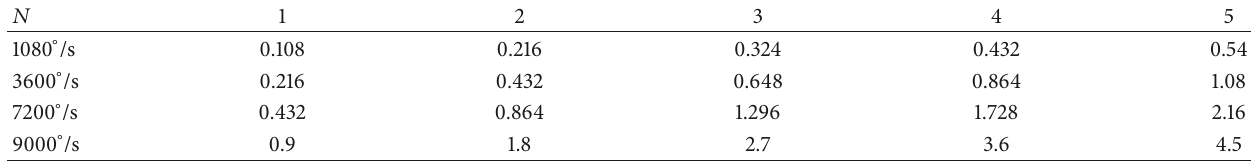
Table 4: Angular increment by conventional structure.